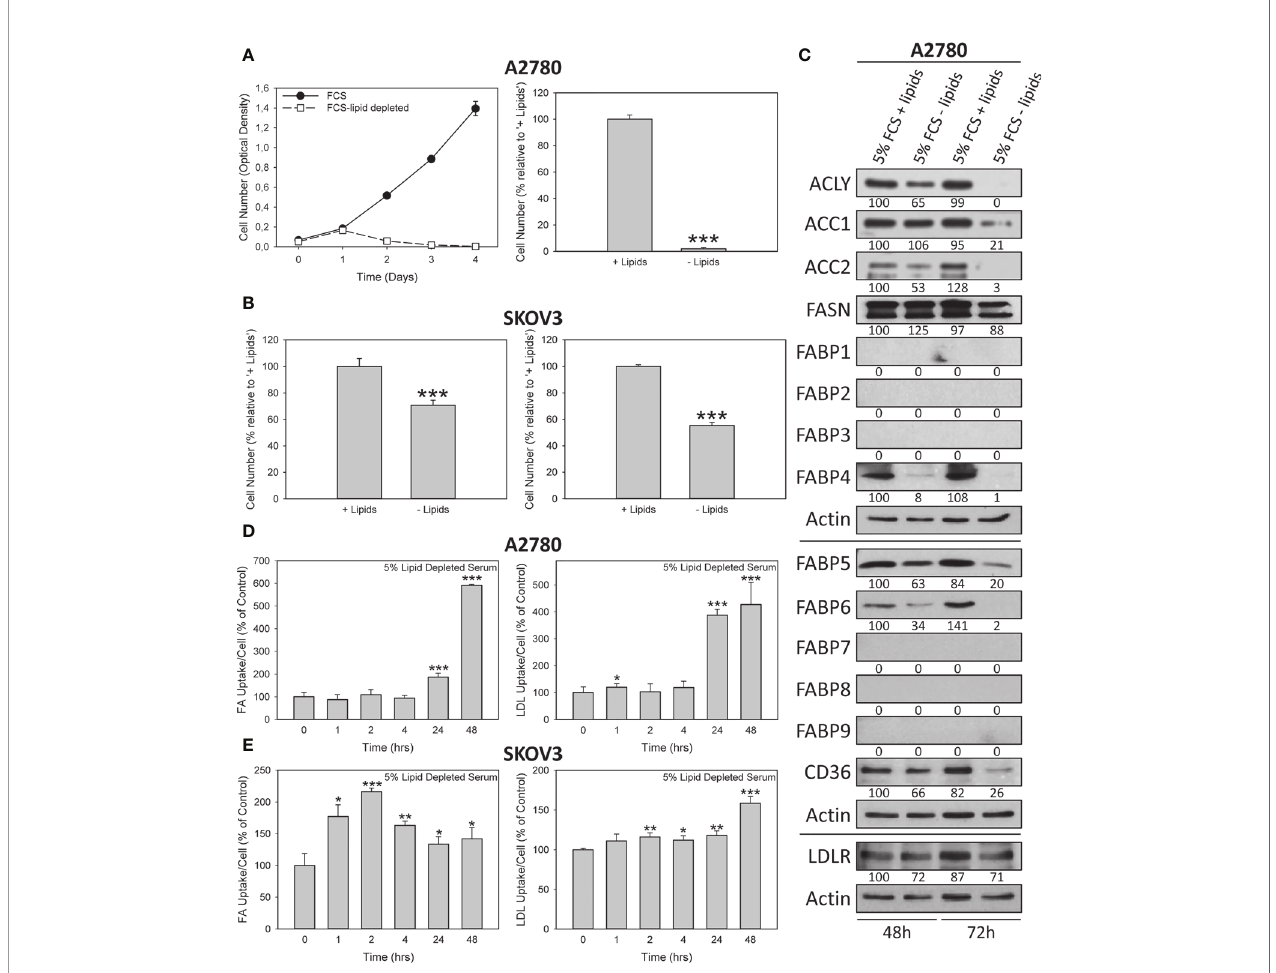
FIGURE 6 | Cultivation of A2780 (A, C, D) and SKOV3 (B, E) OC cells in lipid-free media inhibits growth (A, B) , down-regulates expression of lipid metabolic proteins (C) and conditions the cells for restorative import of exogenously supplied FAs or LDLs (D, E) . Cells were cultured for 0 – 4 days (A, left panel) or for 72 hours ( A , right panel; B both panels) in media containing 5% FCS with or without lipids. Analysis of cell growth was either by formazan dye assay ( A both panels; B left panel) or direct microscopic counting in a hemocytometer ( B right panel). Western blots (C) were (co-)probed for lipid metabolic proteins, stripped if necessary, and re-probed for actin as loading control. The band intensities obtained after chemoluminescence detection of autoradiographs were determined using ImageJ software and the ratios between the proteins of interest and the corresponding actin on the same membrane were calculated. Horizontal lines separate the different membranes. These ratios were normalized to cultures grown for 48 hours in media supplemented with 5% FCS + lipids (arbitrarily set to 100%) and are given under each autoradiograph in percent. Autoradiographs of one of two experiments are shown. For further technical details of cell proliferation experiments, Western blotting, and uptake assays for FAs and LDLs see Materials and methods. Means ± SD, n = 3. Student ’ s t-test (A, B) or ANOVA followed by Scheffe test (D, E) , p < 0.05 (*), p < 0.01 (**) and p < 0.001